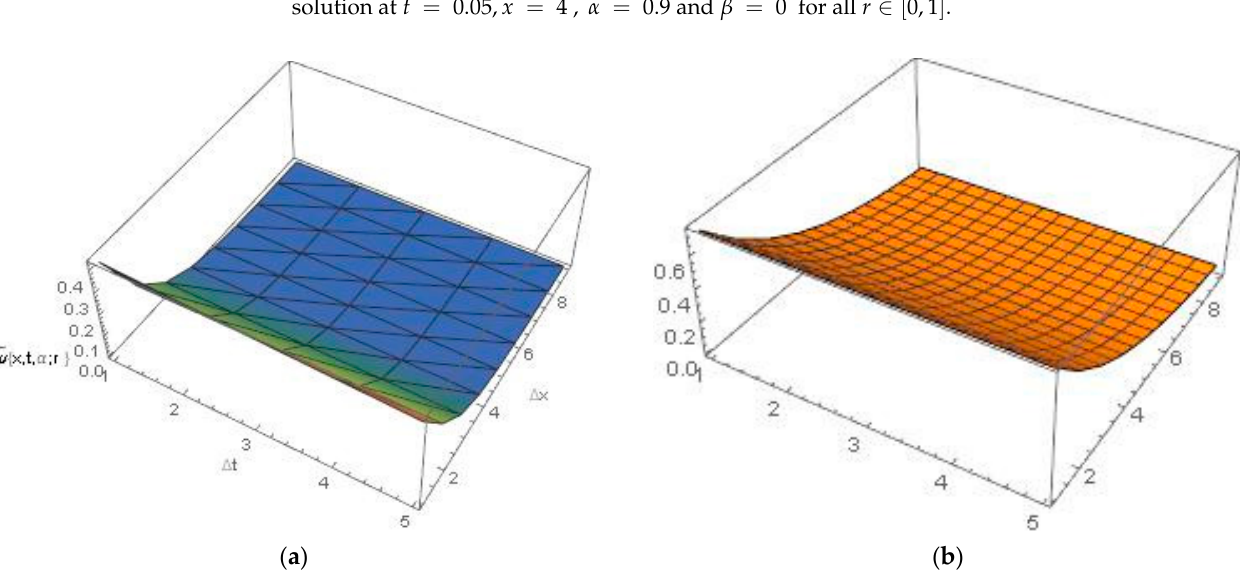
Figure 3. ( a ) Upper numerical solution of Equation (30), by explicit finite difference, ( b ) Upper exact solution at 𝑡 = 0.05, 𝑥 = 4 , 𝛼 = 0.9 and 𝛽 = 1 for all 𝑟 ∈ [0,1] .